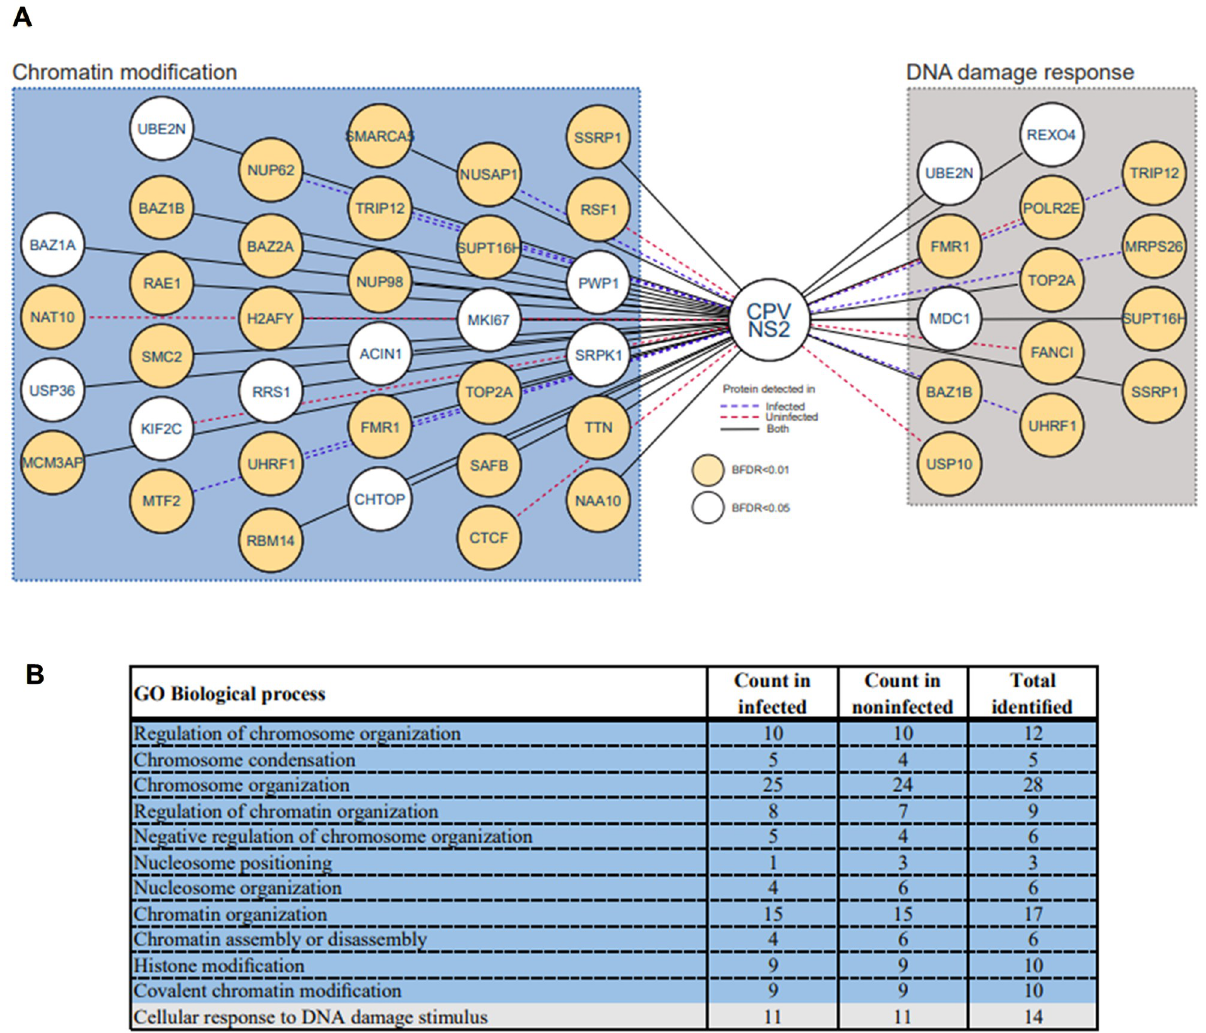
Fig 2. Nuclear interactors of NS2. Identification of NS2 proximity interactome using BioID. ( A ) Schematic picture of 48 high-confidence BioID NS2 interactors related to chromatin modification and DNA damage response cellular processes. Interactors are presented by their gene names. Association of NS2 (HA-BirA � -NS2) is shown either in the presence (24 hpi, dark blue dashed line) or in the absence (red dashed line) of infection or in both cases (black solid line). ( B ) Table showing the GO functional annotation clusters for the NS2 BioID dataset. The functional annotation chart of NS2 high confidence interactors was created by PANTHER classification system for GO Biological process overrepresentation (http://www.pantherdb.org/) using the default BFDR < 0.01 (yellow circle) and < 0.05 (white circle) filters. The GO terms are grouped hierarchically by PANTHER to illustrate relations between functional classes and are colored based on relatedness to the two identified functional association groups: chromatin modification (blue) and DNA damage response (gray).